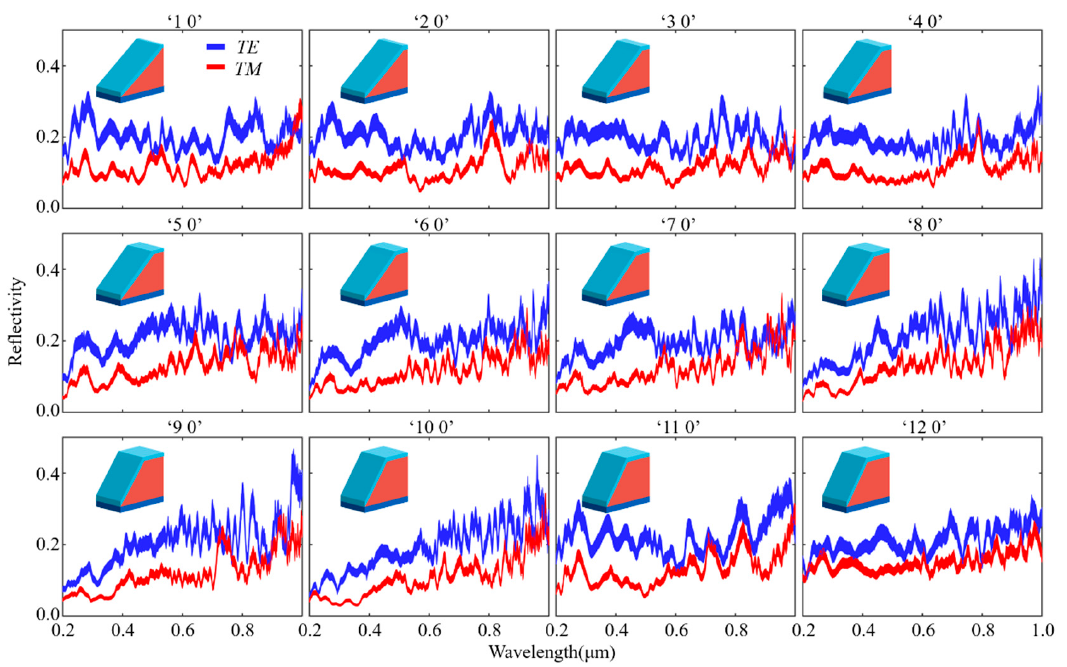
Figure 3. Simulated wavelength-dependent spectra for 12 data sequences (Azimuth fi xed to 0 °) .